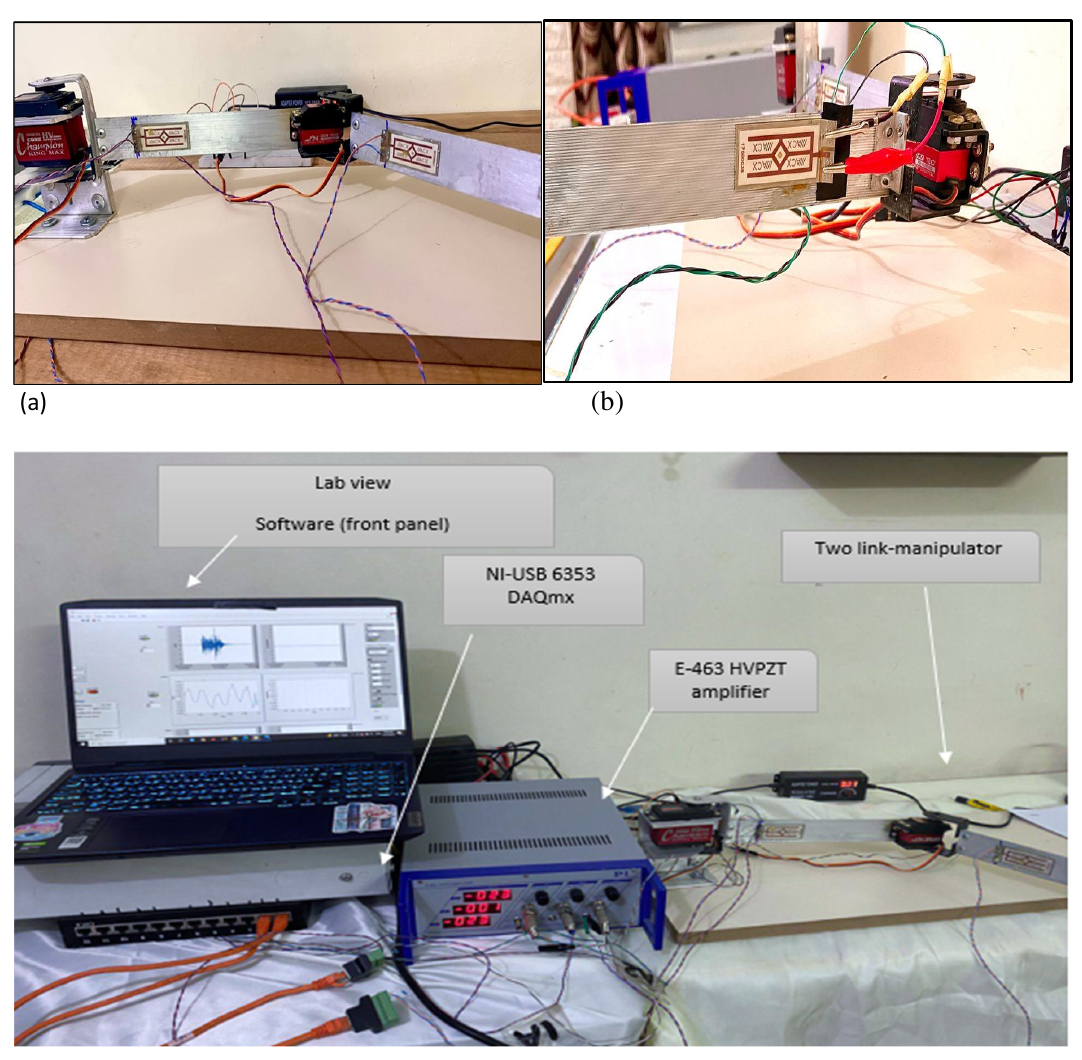
Fig. 6. Experimental system (a) two-link flexible manipulator,(b) the second link bonded with a piezoelectric